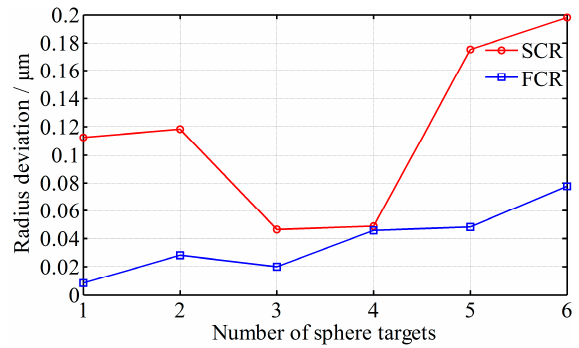
Figure 12. Radius deviation of the six sphere targets with FCR and SCR, respectively.